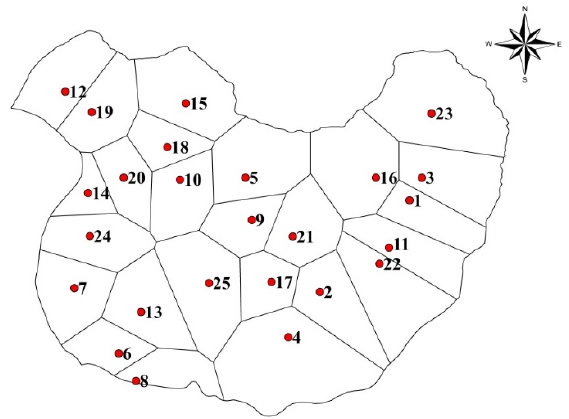
Figure 2. Borehole locations with Thiessen polygons.